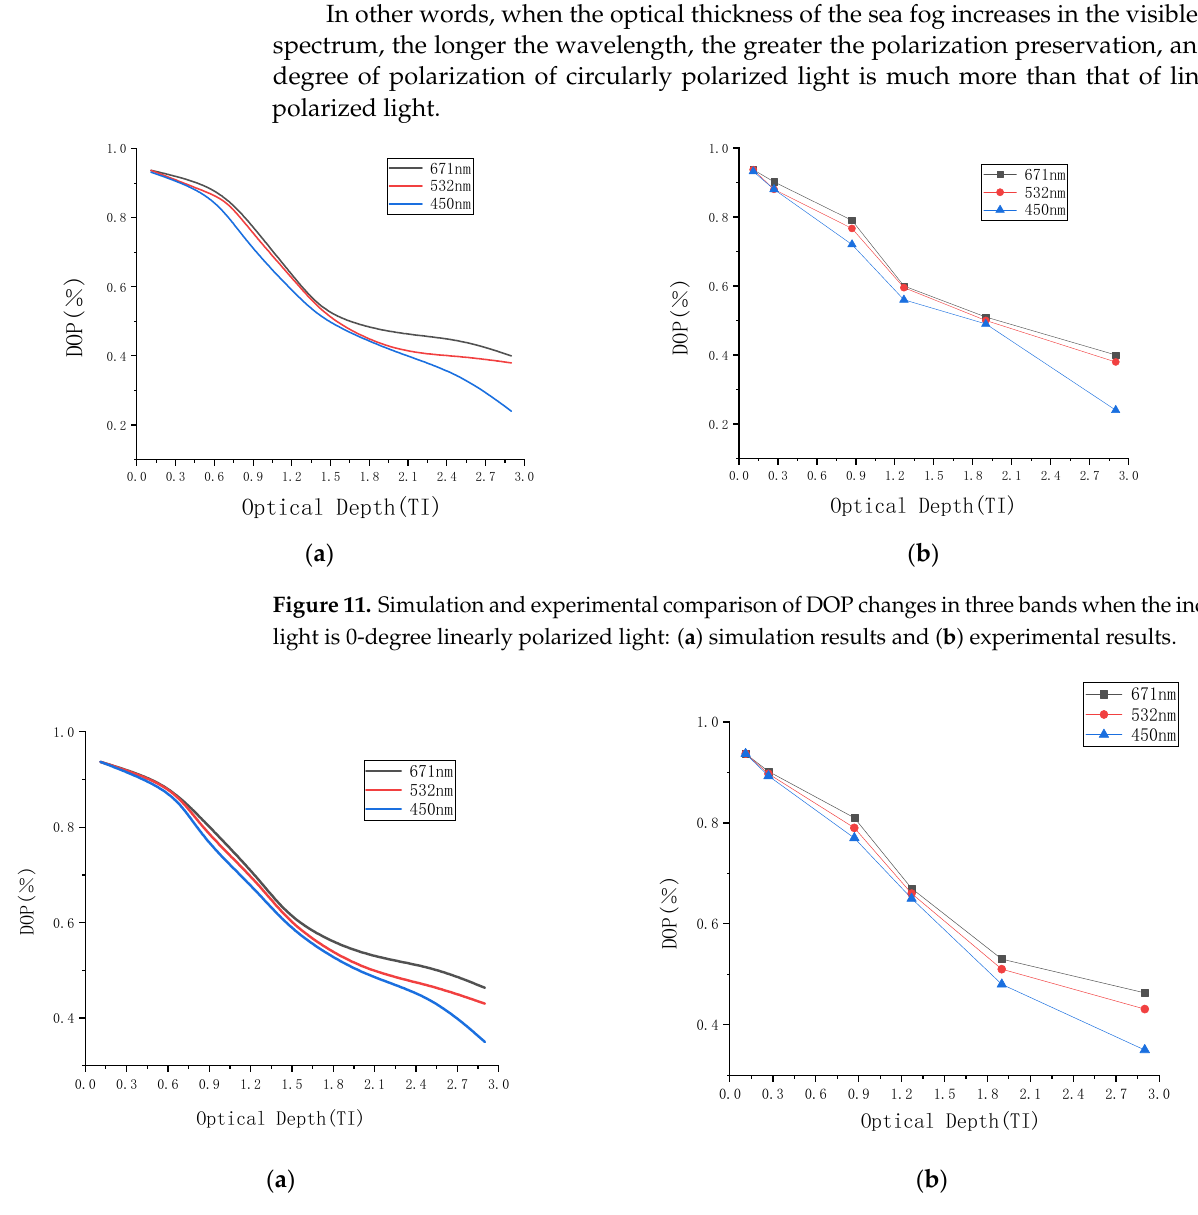
Figure 12. Simulation and experimental comparison of DOP changes in three bands when the incident light is left-handed circularly polarized light: ( a ) simulation results and ( b ) experimental results.